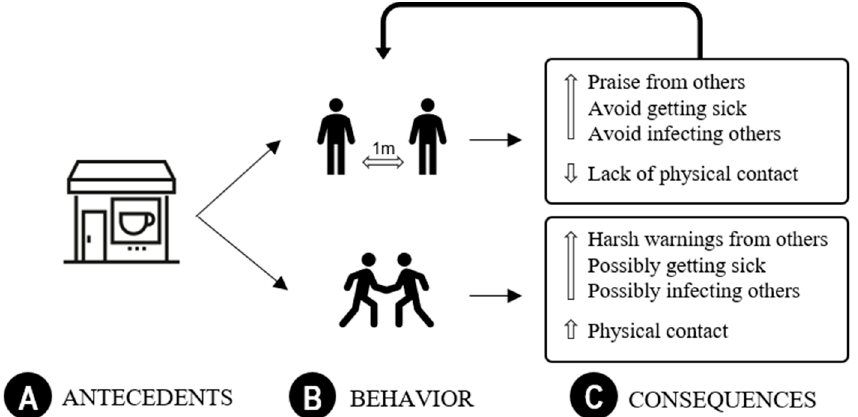
Figure 1. Three-term contingency description of the behavior of greeting a friend keeping physical distance or proximity.